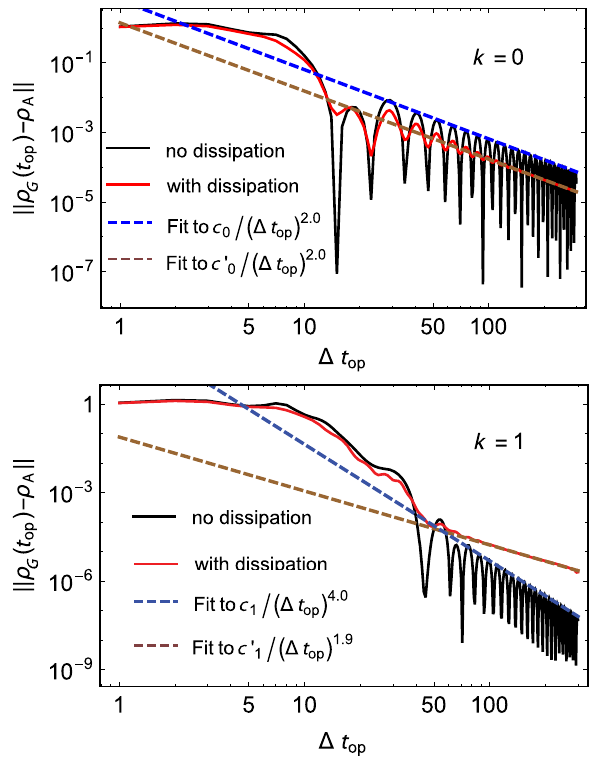
− ρ ∥ , vs the gap multiplied t A G ð op Þ . The parameters are the same op